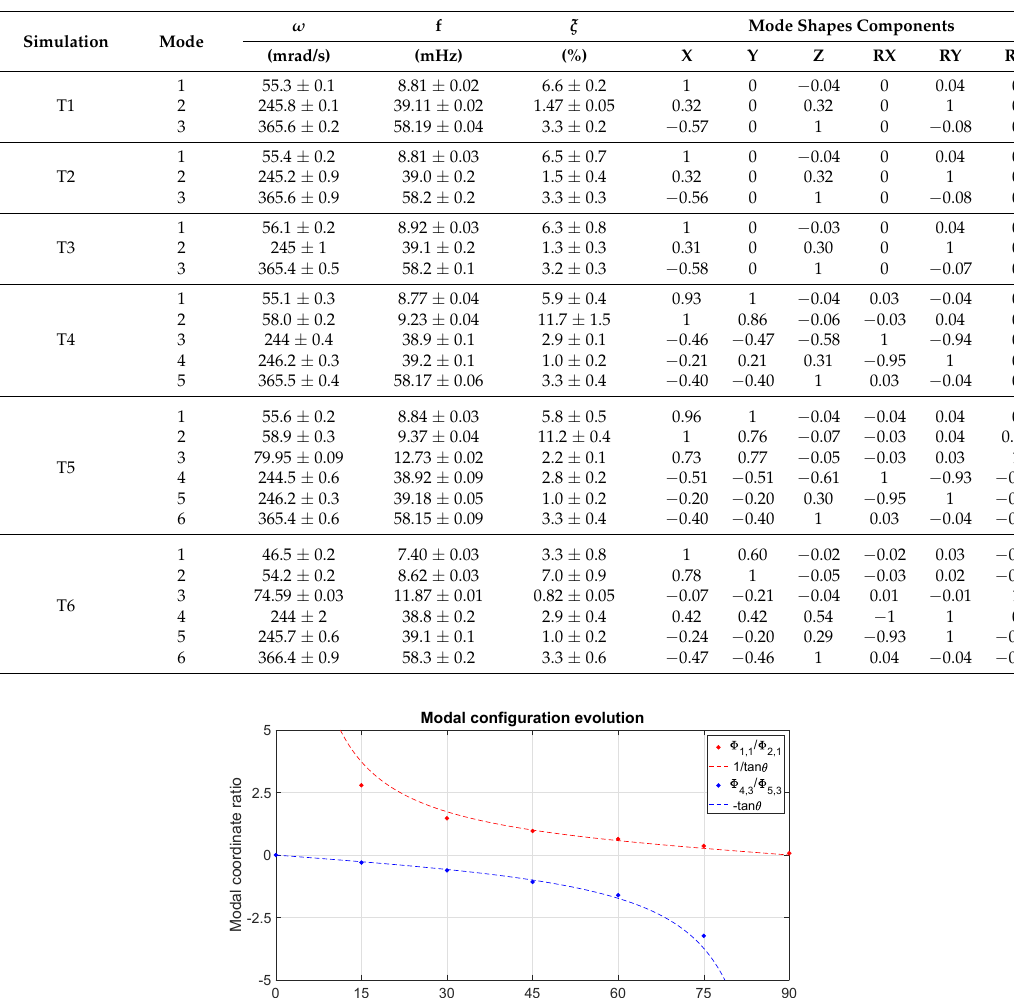
Table 6. Modal properties, including angular frequencies, natural frequencies, modal damping ratios, and 6 mode shape components obtained for the different simulations (X-surge; Y-sway; Z-heave; RX-roll; RY-pitch; RZ-yaw).